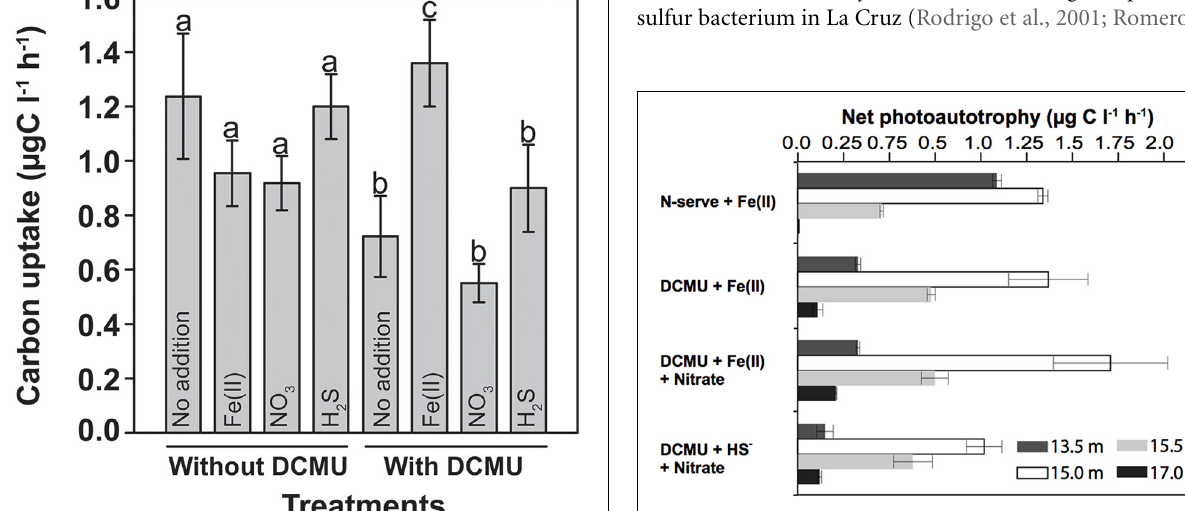
FIGURE 3 | Light-dependent inorganic carbon uptake in presence of potential substrates for lithoautotrophic iron- and sulfur-transforming microorganisms. In-situ net photosynthetic carbon fixation experiments showing a statistically significant stimulation upon Fe(II) addition in presence of DCMU (- c -, p < 0 . 05) that inhibits oxygen production by photosynthesis. The net photosynthetic carbon uptake was obtained by subtracting the dark incubation values from the carbon uptake in the light. Letters represent the statistical groups using generalized linear models. Average values and standard deviations are presented (13/Oct/2008).